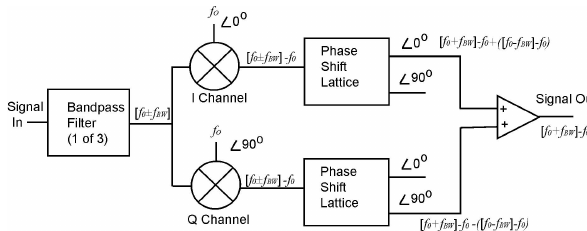
Fig. 1. Diagram showing the Cluster WBD frequency conversion chain for down converting a signal received at higher frequency [ f 0 + f BW ] to one at baseband frequency ( f 0 =